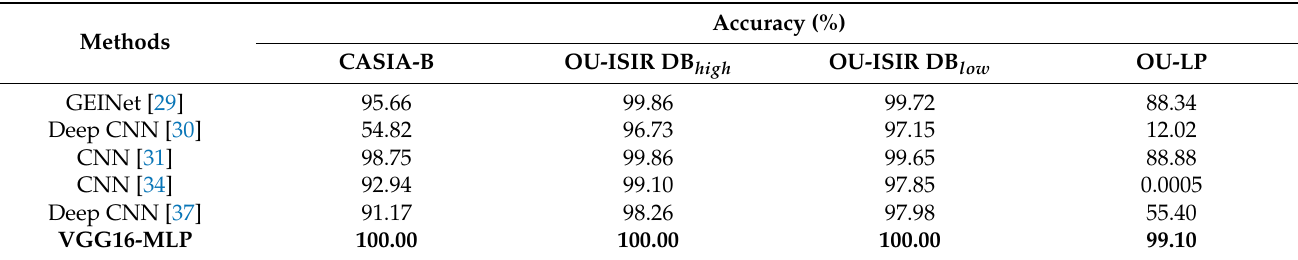
Table 8. Comparison results on different